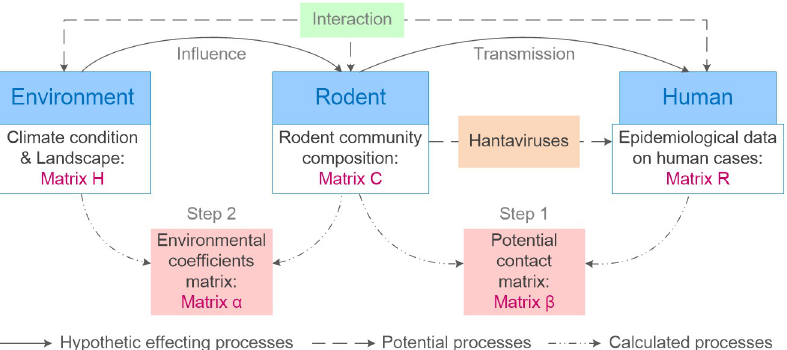
Fig 2. Hypothetical processes affecting the environment, rodents, and humans, and the matrix calculations. Words shown in blue are the monitored objects and pink boxes are the main coefficients that we calculated. All the matrices are named and emphasized in plum color. Green boxes represent potential interaction processes and orange boxes represent the viruses that couldn’t surveyed directly.